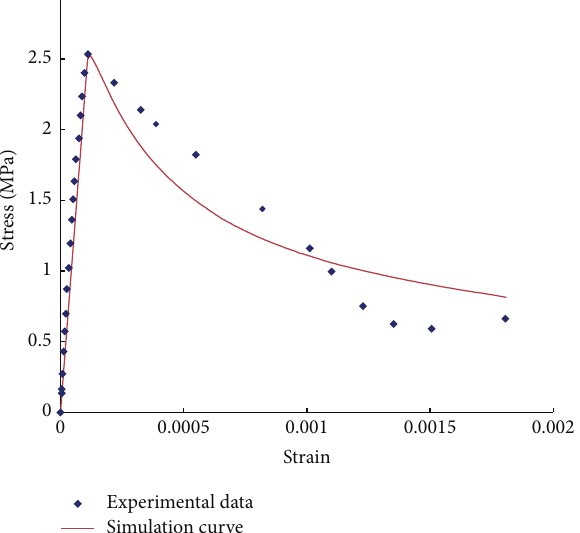
Figure 10: Comparison of stress-strain relationship between numerical simulation and experimental tests for specimen